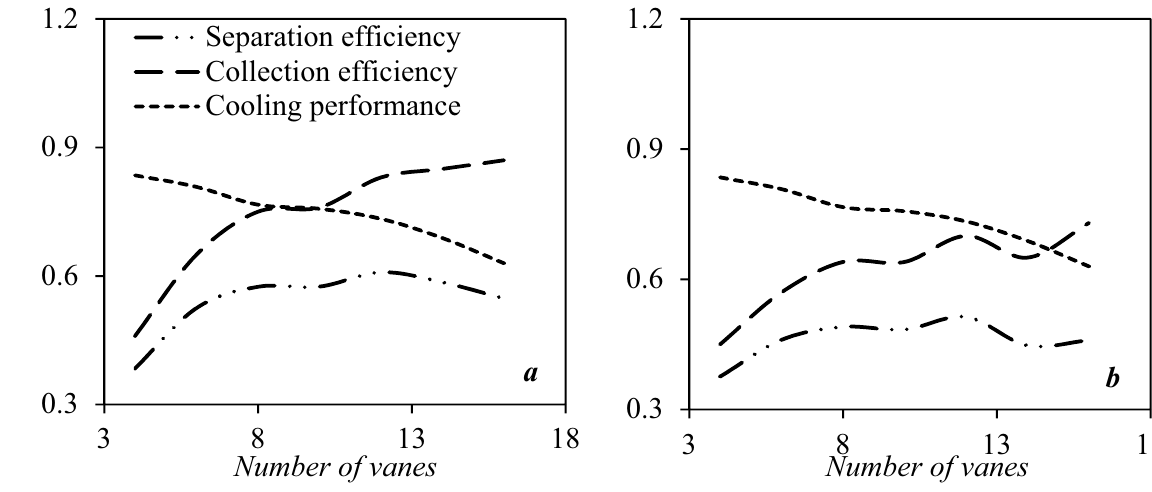
Figure 12. The influence of number of static vanes on the collection efficiency, cooling performance and separation efficiency of 3S for ( a ) water droplets and ( b ) HC droplets.